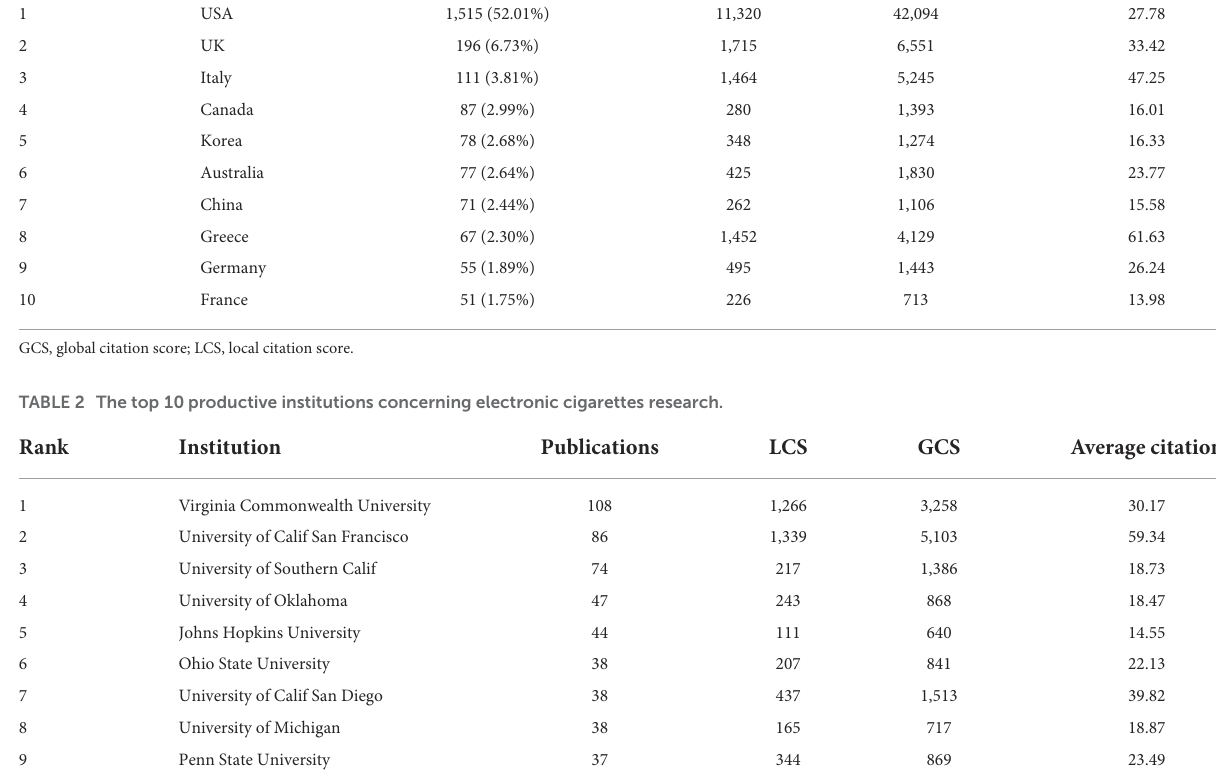
(Supplementary Table 1). The silhouette value measures